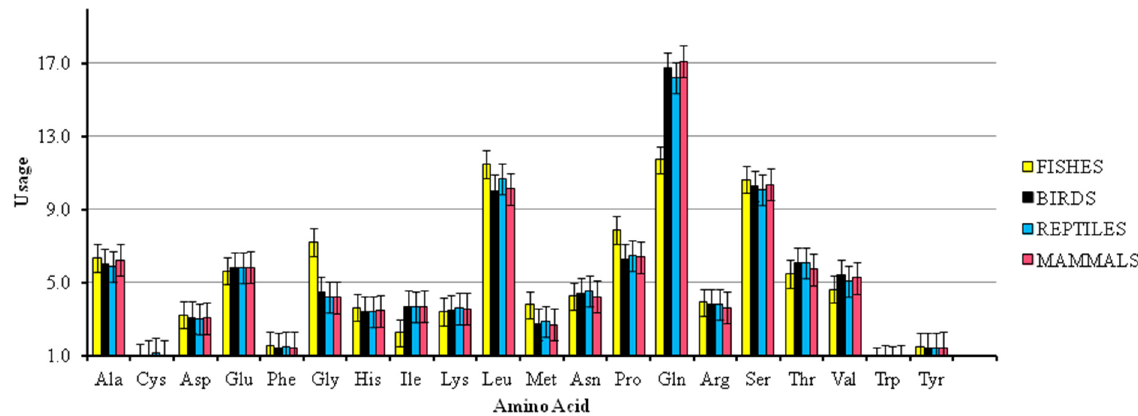
Figure 7. Overall frequency of amino acids used in the Foxp2 gene among various species of fishes, reptiles, birds, and mammals. The amino acids glutamine (Gln), leucine (Leu), and serine (Ser) were predominant over other amino acids.